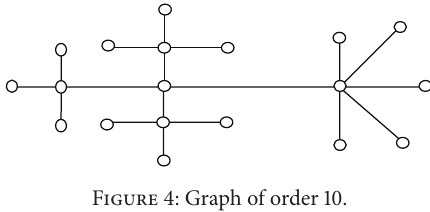
Figure 2: Graph of order 7.